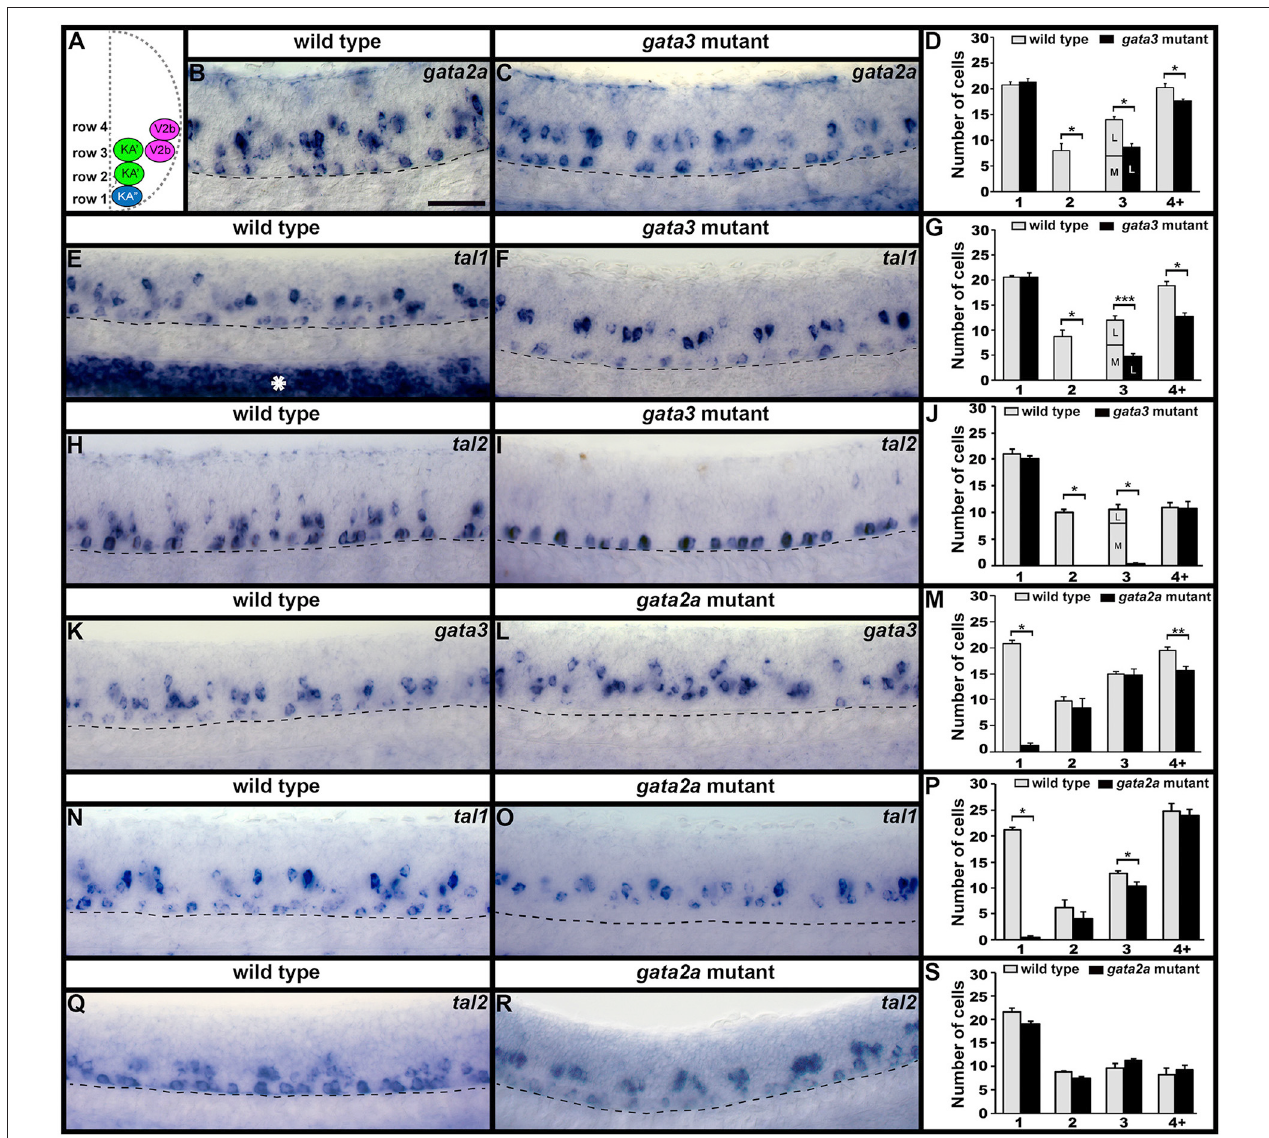
FIGURE 3 | gata2a , gata3 , tal1, and tal2 expression in KA ′′ , KA ′ , and V2b neurons is differentially regulated by gata3 and gata2a . (A) Cross-sectional schematic indicating positions of KA ′′ , KA ′ , and V2b neurons. Lateral views of gata2a (B,C) , tal1 (E,F,N,O) , tal2 (H,I,Q,R), and gata3 (K,L) expression in 24h WT siblings (B,E,H,J,N,Q) and gata3 (C,F,I) and gata2a (L,O,R) mutants. Dorsal, top; in lateral views, anterior, left. White asterisk in (E) indicates blood expression of tal1 . Dashed lines indicate ventral limit of spinal cord. Scale bar = 50 microns. Mean number of cells expressing each gene in each D/V row of spinal cord region adjacent to somites 6–10 (D,G,J,M,P,S) . For gata3 mutant results (D,G,J) the approximate proportions of medial and lateral row 3 cells are indicated by horizontal lines separating the number of medially-located cells (bottom and indicated with an “M”) from the number of laterally-located cells (top and indicated with a “L”). All of the remaining gata2a- and tal1 -expressing cells in row 3 of gata3 mutants were located laterally, suggesting that they are V2b cells and that no KA ′ cells express these genes in gata3 mutants. More dorsal (row 4 and above) cells expressing tal2 in gata3 mutants (I) are more weakly stained than the strongly stained KA ′′ cells and are in a different focal plane. All counts are an average of at least 4 embryos. Error bars indicate SEM. Statistically significant comparisons are indicated with brackets and stars. *** P < 0.001, ** P < 0.01, * P < 0.05. For P- values see Supplementary Table 3.